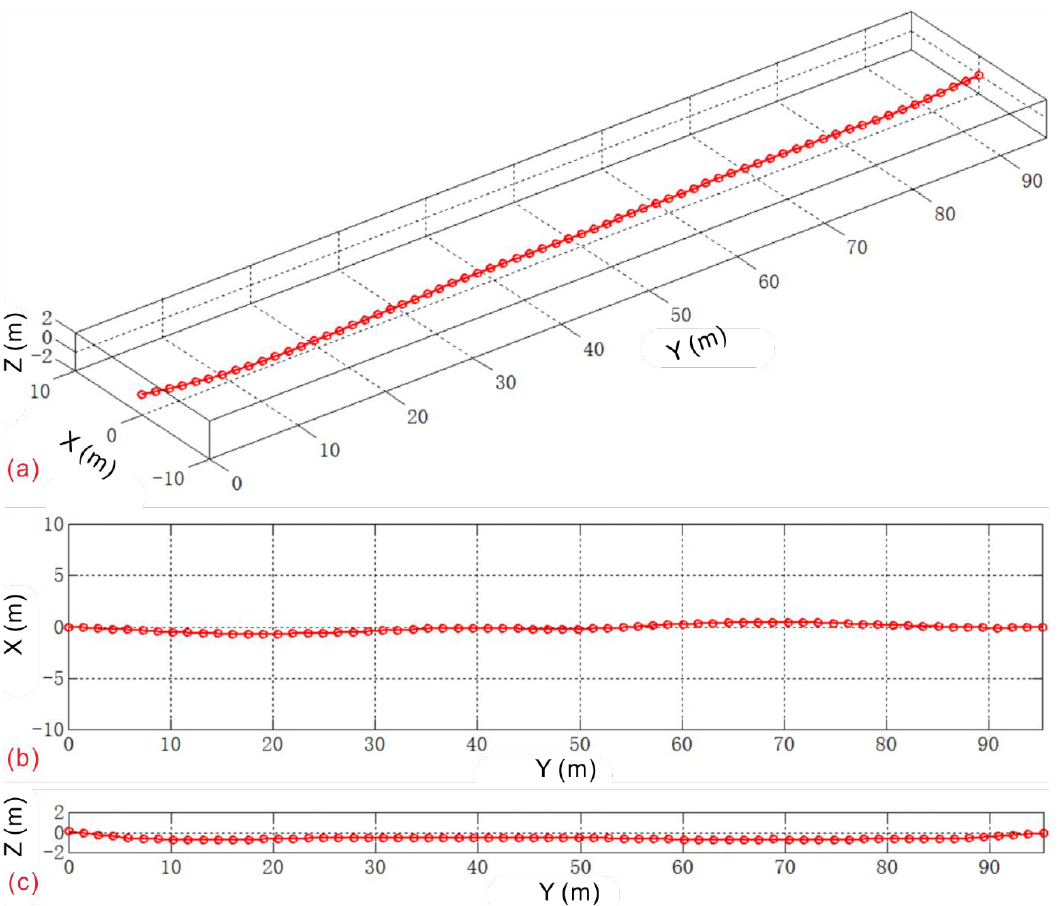
Figure 13. Initial pipeline trajectory curve of field test: ( a ) Axonometric view; ( b ) X–Y plane view; ( c ) Y–Z plane view.